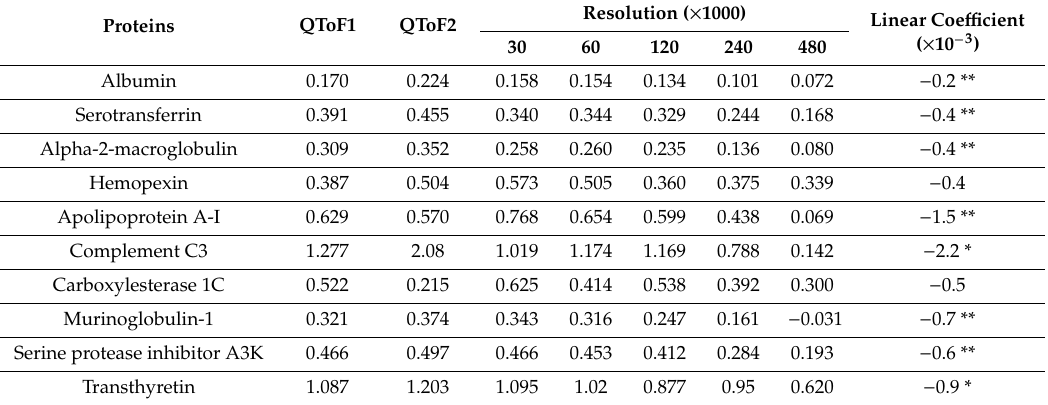
Table 2. Rate constants (day − 1 ) of the ten abundant proteins in the murine serum blood samples [16] computed using d2ome. The same samples were analyzed at different values of mass resolution. Additionally shown is the coefficient of the linear regression on the mass resolution for each protein.